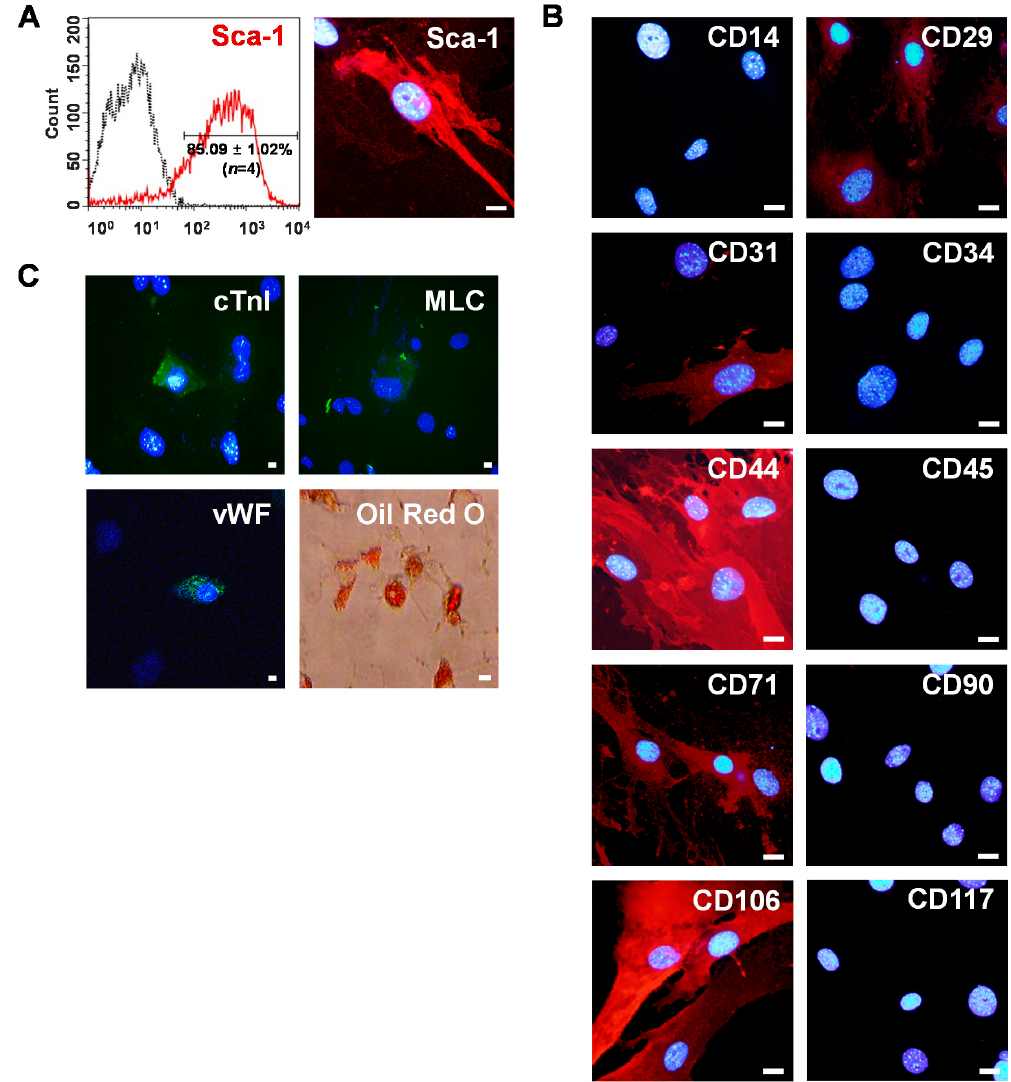
Figure 1. Isolation of mouse Sca-1+ CSCs from adult heart. ( A ) Sca-1+ CSCs were enriched by MACS with PE-conjugated anti-Sca-1 antibody and anti-PE micro beads. After sorting four rounds, ~86% of the cells expressed Sca-1 as determined by flow cytometry ( left ). CSCs expressing intense Sca-1 signals were observed under confocal microscopy after immunostaining with anti-Sca-1 antibodies ( right ). Scale bars = 20 µm; ( B ) characterization of Sca-1+ CSCs. Sca-1+ CSCs were stained with anti-CD14, -CD29, -CD31, -CD34, -CD44, -CD45, -CD71, -CD90, -CD106, and CD117 antibodies and visualized with Alexa Fluor 594 secondary antibodies (red). Scale bars = 20 µm; and ( C ) differentiation potential of Sca-1+ CSCs. Cardiac, endothelial, and adipogenic differentiation were confirmed by immunostaining with cardiomyocyte markers (cTnI, MLC, green), an endothelial marker (vWF, green), and Oil-Red O staining (red), respectively. Nuclei were stained with DAPI (blue). Scale bars = 20 µm.